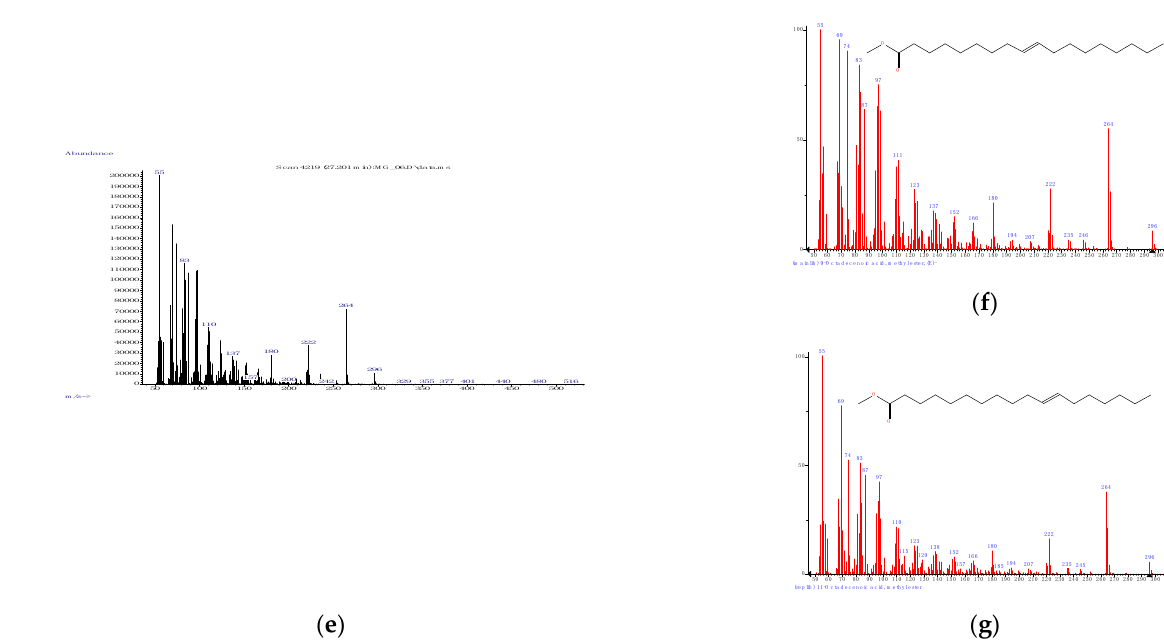
Figure 6. Experimental (left) and from the NIST 2011 database (right) mass spectra for the main fatty acids (as methyl esters) identified in the derivatized lipid fractions from Mangalitza hard fat—Monounsaturated fatty acids (MUFAs): palmitoleic acid ( a , b ), oleic acid ( c , d ), and vaccenic/elaidic acid ( e – g ).